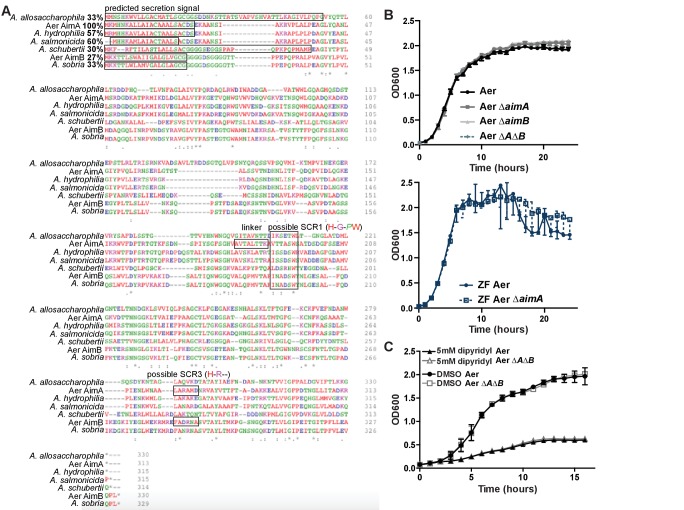
Homologues to AimA are found across the Aeromonas genus.(A) Clustal Omega alignment of six AimA homologues with AimA. The predicted secretion signal, the linker between the N- and C-term, and two possible lipocalin SCRs are indicated on the alignment. (B) In vitro growth curves of Aer ΔaimA, Aer ΔaimB, and Aer ΔAΔB in A. veronii strain Hm21, and ZF Aer ΔaimA in the zebrafish Aeromonas background do not have growth defects in vitro. (C) In vitro growth curves of wild type Aeromonas (Aer) and Aer ΔAΔB grown in iron limiting conditions (+dipyridyl) or with a vehicle control (DMSO).10.7554/eLife.37172.023Figure 5—figure supplement 1—source data 1.Homologues to AimA are found across the Aeromonas genus.